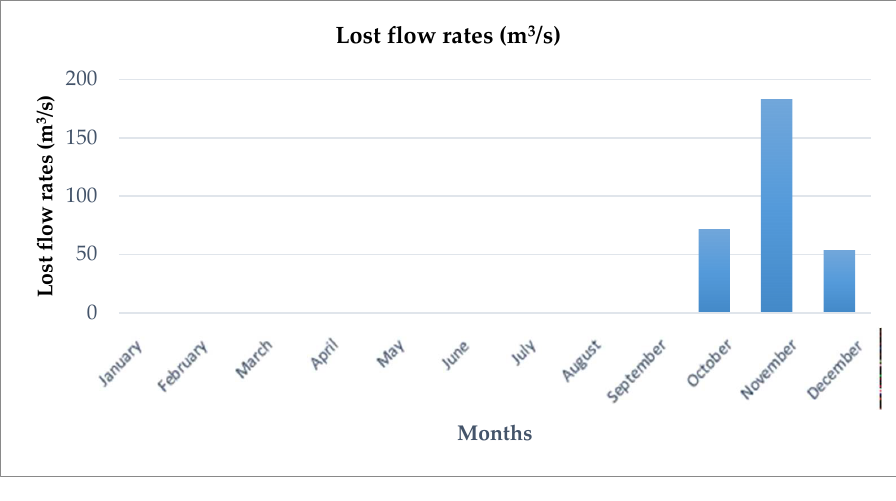
Figure 12. ( a ) Average monthly electrical energy histogram and ( b ) average daily electrical energy curve.